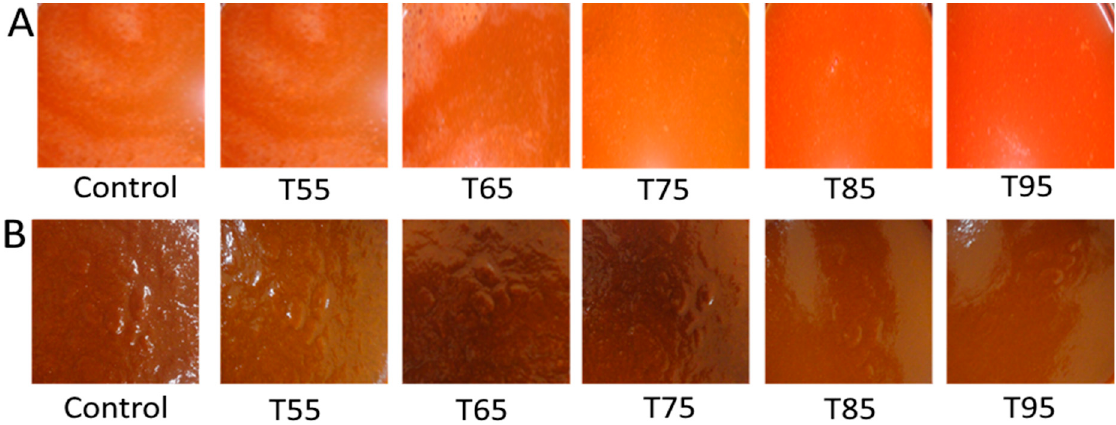
Figure 3. Effect of heat treatments on currant tomato. Pulp ( A ) and paste ( B ). In Figure 3 ( A , B ), T55 to T95 represent coded temperature values for cold- and hot-break heat treatments, respectively. Table 2. Effect of heat treatments on the color parameters of currant tomato pulp and paste 1 .